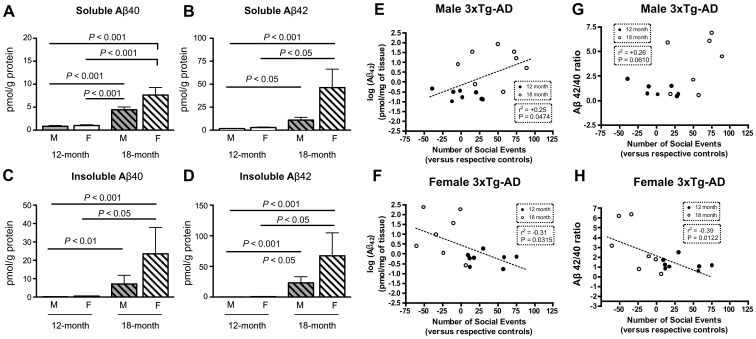
Age-dependent accumulation of Aβ peptides in soluble and insoluble protein fractions in 3xTg-AD mice.(A–D) ELISA (Aβ) measurements showing Aβ40, Aβ42 accumulation with age as quantified in the TBS-soluble (soluble proteins) and the formic acid-soluble (insoluble proteins) fractions from the frontal cortex of 3xTg-AD mice. Consistent trends toward increases were seen in female 3xTg-AD mice compared to males but did not reach statistical significance. Values are expressed as means ± SEM (n = 8 per group). (E–H) To evaluate the relation between Aβ load and social behaviour, the number of social events displayed by 3xTg-AD mice (relative to its NonTg partner) was plotted against the Aβ42 concentrations or Aβ42/40 ratio in the frontal cortex. A significant correlation could be established across the 2 groups of age (dotted lines).